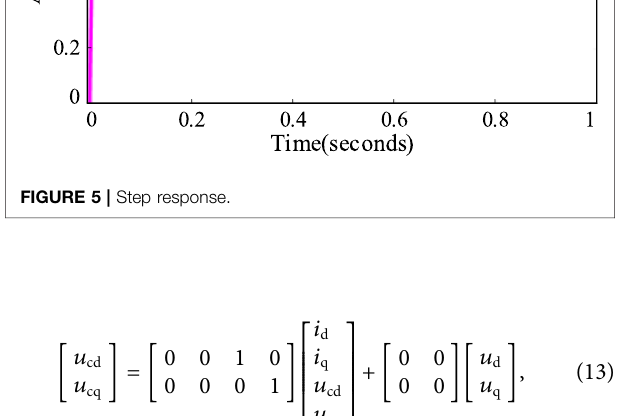
FIGURE 6 | Adaptive virtual impedance